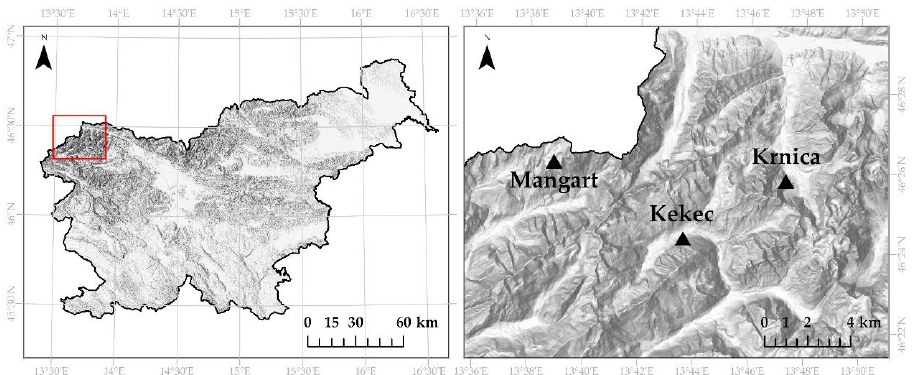
Figure 1. Locations of rockfalls (Slovenia) that were selected as study sites. Remote Sens. 2021 , 13 , x FOR PEER REVIEW